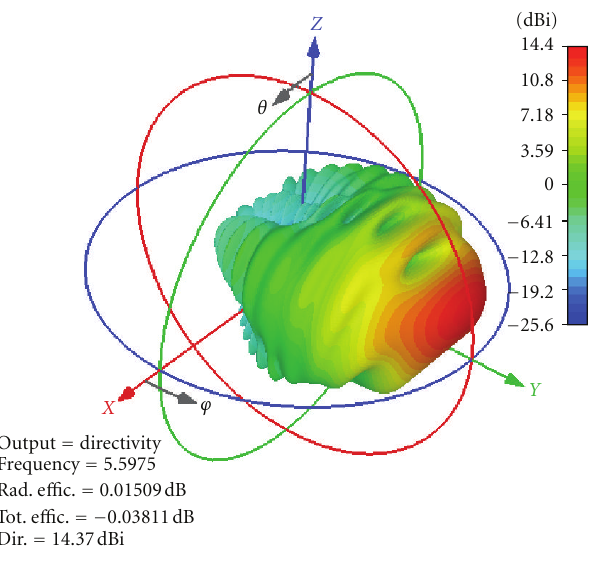
Figure 20: Simulated radiation pattern in 3D (directivity) of Yagi antenna at 5.6 GHz.